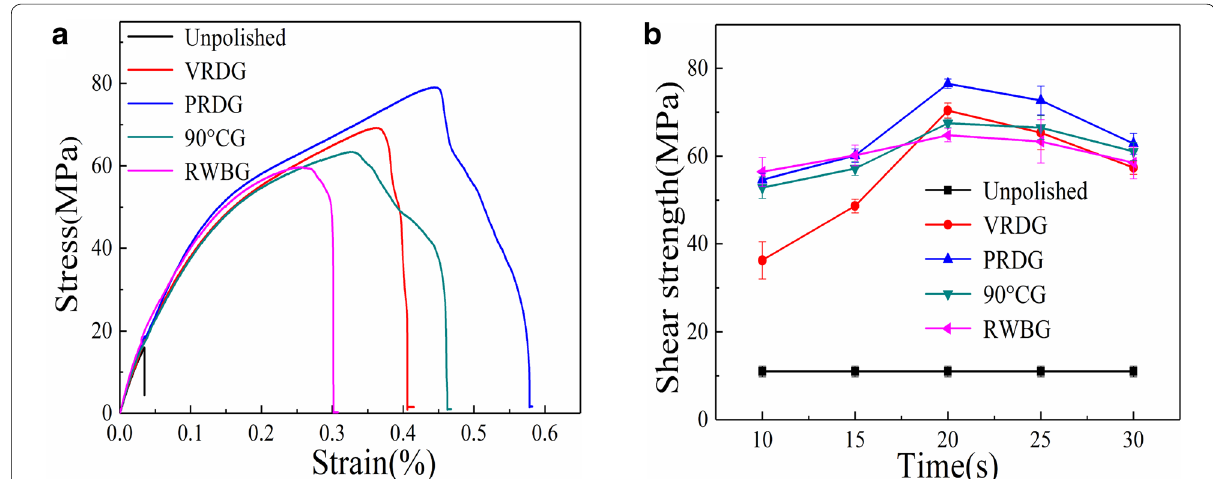
Fig. 6 Shear strength of Cu/Al clad plates with different mechanical treatments: a stress–strain curves of samples treated for 20 s; b statistics of shear strength